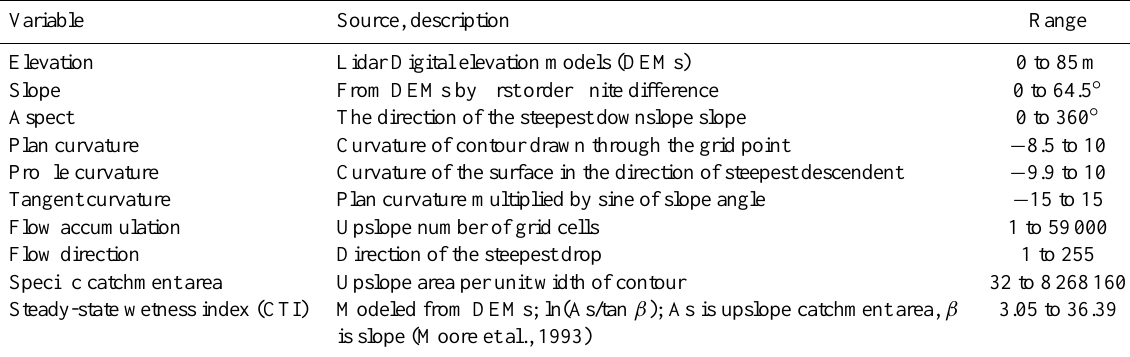
Table 1. The different terrain parameters (predictors) extracted from DEMs likely to impact on the organic/mineral soil distribution and their corresponding